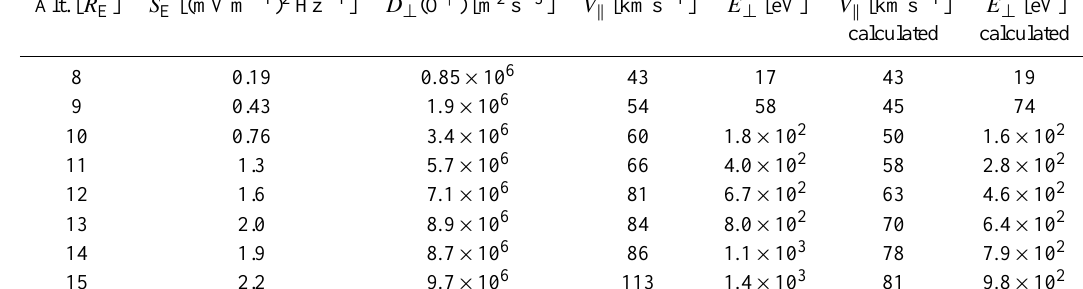
summary of the test particle calculation. Table 1. Summary of the perpendicular diffusion coefficient for O + , the electric field spectral density at the local oxygen gyrofrequency,